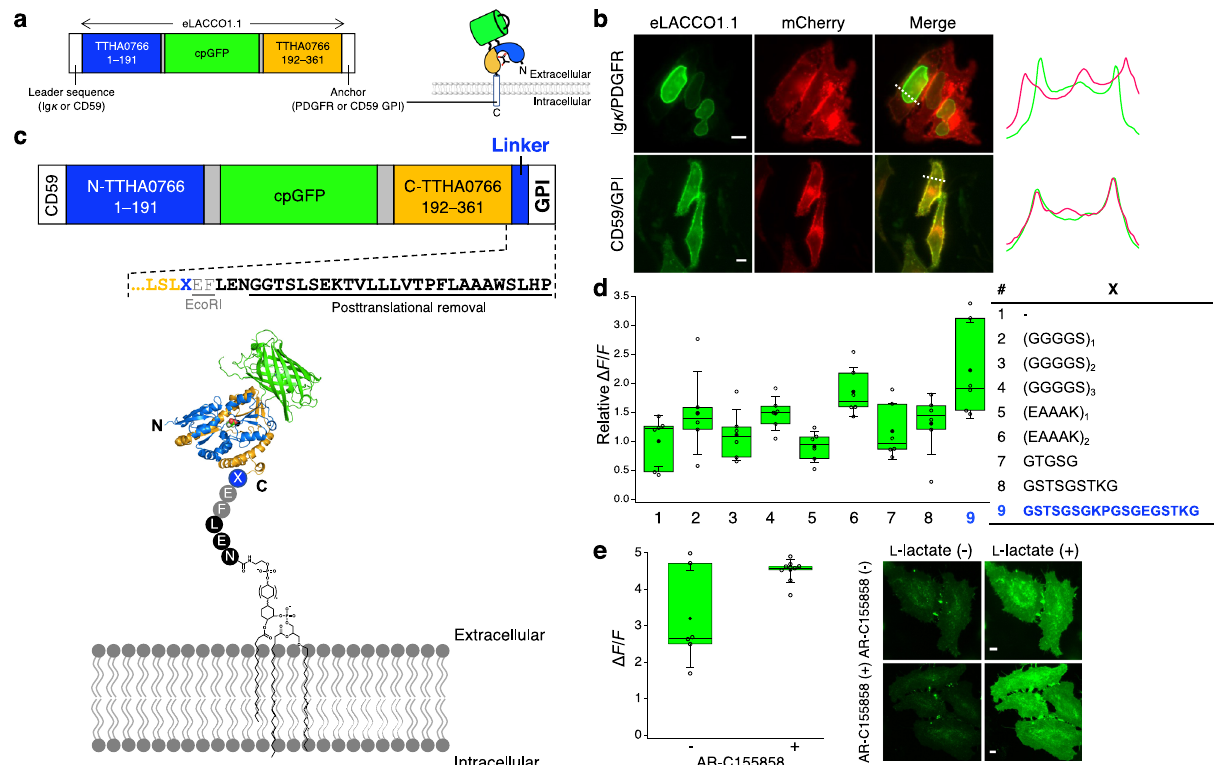
Fig. 3 Targeting of eLACCO1.1 to the extracellular environment. a Schematic representation of the domain structure of eLACCO1.1 with N-terminal leader sequence and C-terminal anchor domain. b Localization of eLACCO1.1 with different leader sequences and anchors in HeLa cells. mCherry red fl uorescent protein (RFP) with Ig κ leader sequence and PDGFR transmembrane domain was used as cell surface marker. Line-scans (right) correspond to dashed white lines on the merged images. eLACCO1.1 with CD59-derived leader and anchor domain is expressed on cell surface as indicated by colocalization with cell- surface-targeted mCherry. Similar results were observed in more than 10 cells. Scale bars, 10 μ m. c Schematic representations of the eLACCO1.1 on cell surface with CD59 leader sequence and CD59 GPI anchor. Underlined sequence is removed after the translation, followed by GPI labeling to the C-terminal Asn (N) residue. d Relative Δ F / F of a range of eLACCO1.1 linker variants. The linker GSTSGSGKPGSGEGSTKG has been demonstrated to reduce aggregation and be resistant to proteolysis 47 . n = 6 cells for each linker variant. e Δ F / F of the linker-optimized eLACCO1.1 in the presence and absence of 1 μ M AR- C155858. n = 6 and 9 cells for AR-C155858( − ) and AR-C155858( + ), respectively. Two-tailed student ’ s t -test with Welch ’ s correction, P > 0.05. Scale bars, 10 μ m. In the box plots in d , e , the horizontal line is the median; the top and bottom horizontal lines are the 25th and 75th percentiles for the data; and the whiskers extend one standard deviation range from the mean represented as black fi lled circle. Source data of d , e are provided as a Source Data fi